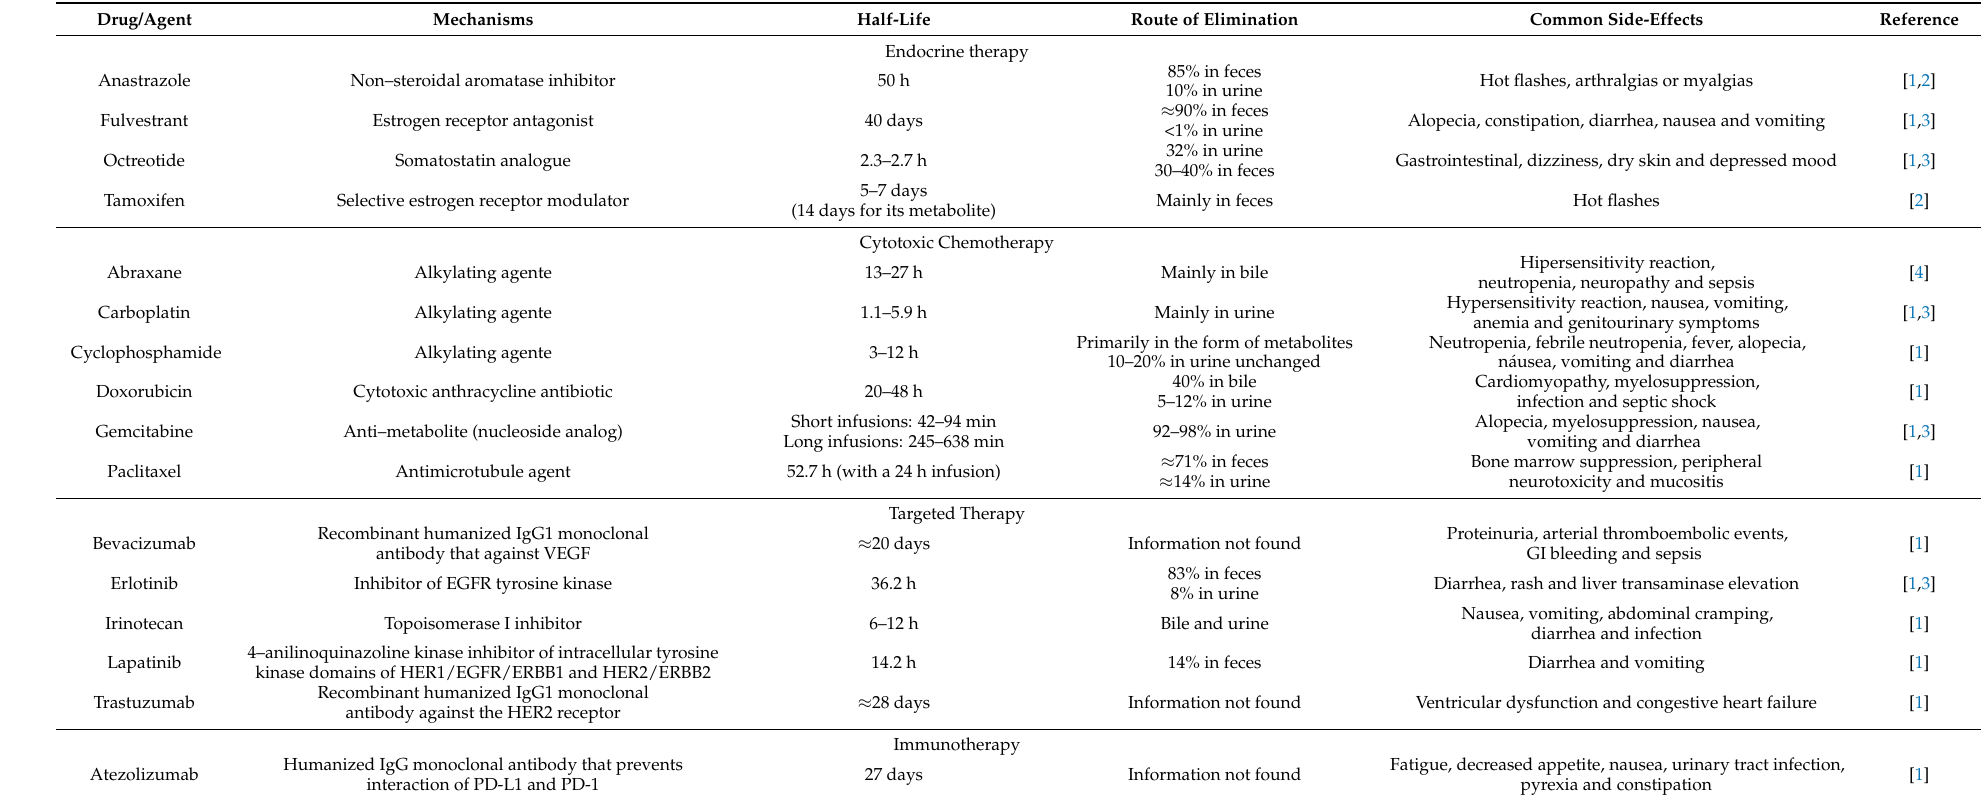
Table 1. Commonly used drugs in the treatment of breast